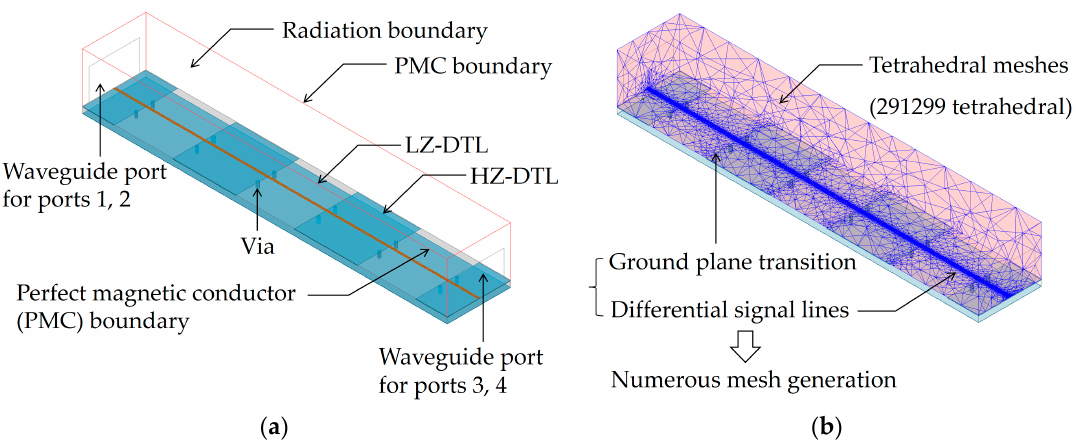
Figure 5. ( a ) Finite element method (FEM) simulation model, and ( b ) mesh generation result of CGP-EBG MTM-DTLs with three unit cells.